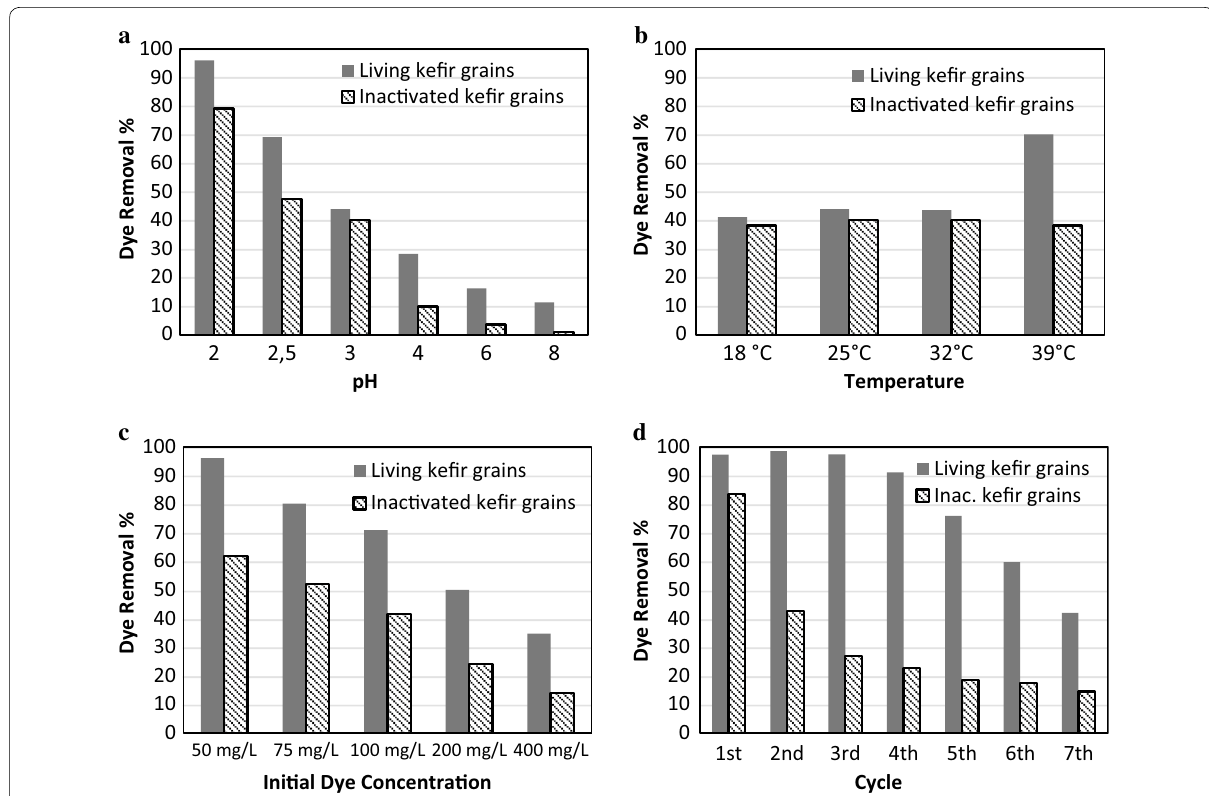
Fig. 1 Dye removal % by kefir grains: a at different pH values (C dye (C dye 100 mg/L, C Kefir = (C Kefir 2.4 g/L, C dye =